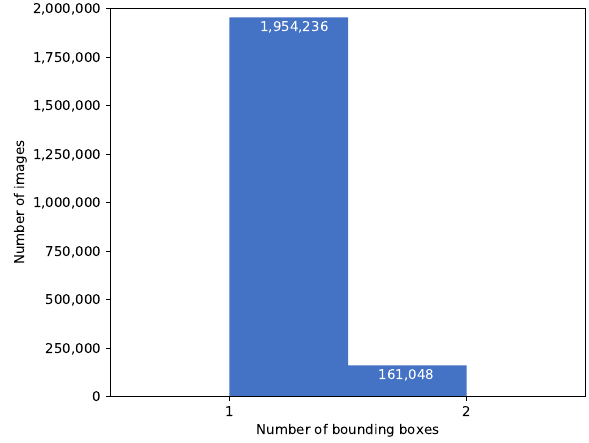
Figure 6. A number of images with respect to bounding boxes per image for our proposed LSUN-Standford car dataset. It can be seen clearly that, in the majority of images, there is just a car present, while in a few images there is a car with a driver (i.e., in images with two bounding